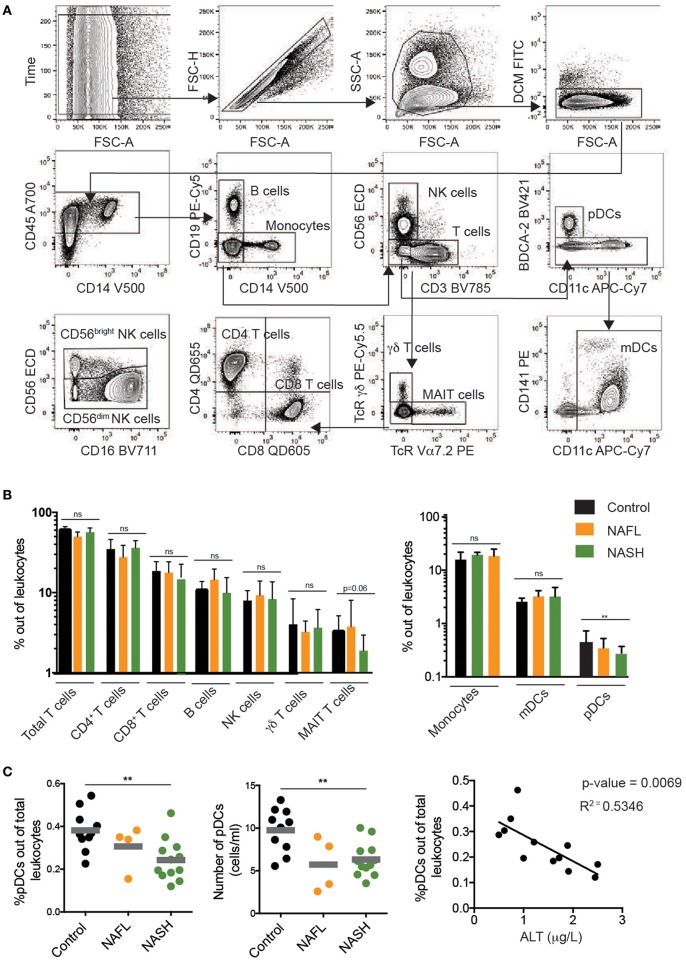
Immunophenotyping of major peripheral blood immune cell subsets in NAFL and NASH. (A) Flow cytometry gating scheme used to identify the investigated immune cell subsets. Arrows indicate the sequence of gating. (B) Summary data for the frequency out of total leukocytes for the indicated immune cell populations in healthy controls (n = 10), NAFL (n = 4), and NASH (n = 11) patients. (C) Summary data of pDC frequency out of total leukocytes (left), absolute counts of pDCs (middle), and correlation between pDC frequency and ALT (right) in the indicated patient groups. Bars in (B,C) represent mean and error bars show SEM. **p < 0.01.